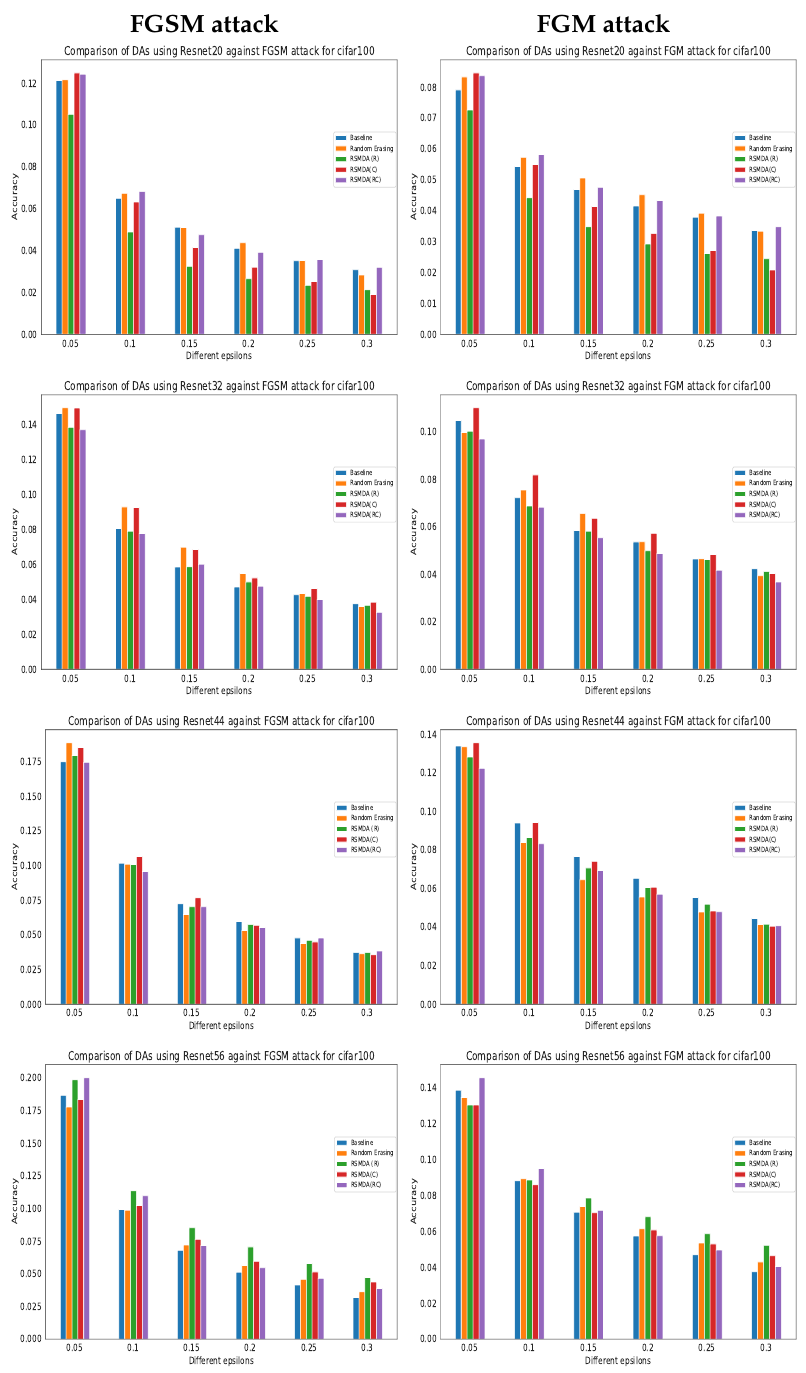
Figure 5. Comparison of DAs against different adversarial attacks for CIFAR100 dataset using different